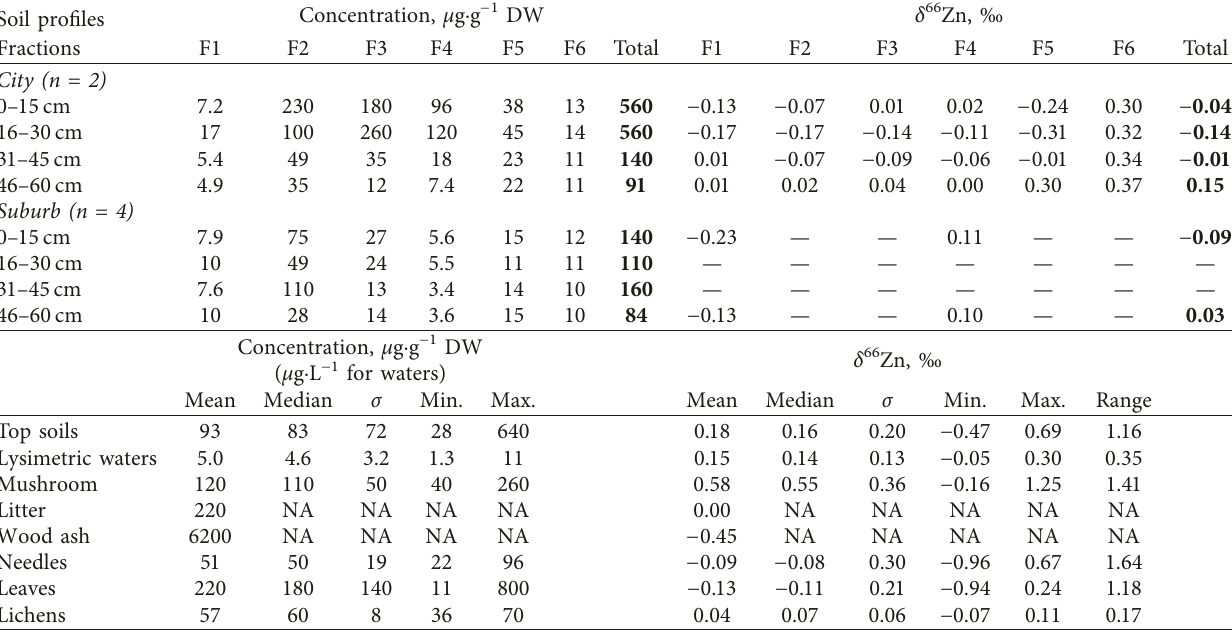
Table 12: Zinc concentrations and isotopic composition in environmental samples from Lule˚a.